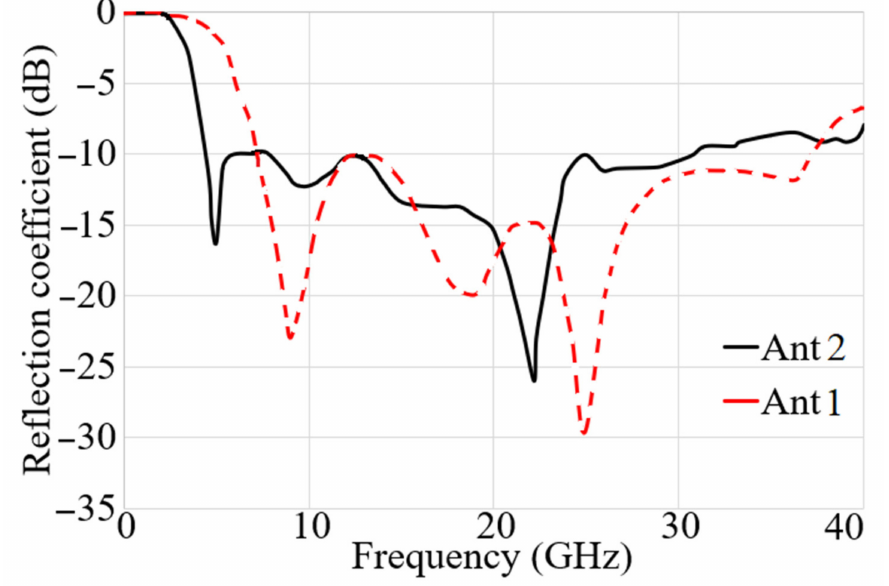
Figure 5. S 11 results of both antennas. Both antennas were combined to form the proposed UWB-MIMO with both vertical and horizontally polarization antenna, which would be used in a communication system for lower and higher 5G, X-band, Ka and Ku, and satellite communications. Figure 6 depicts the proposed antenna’s 2D views following integration